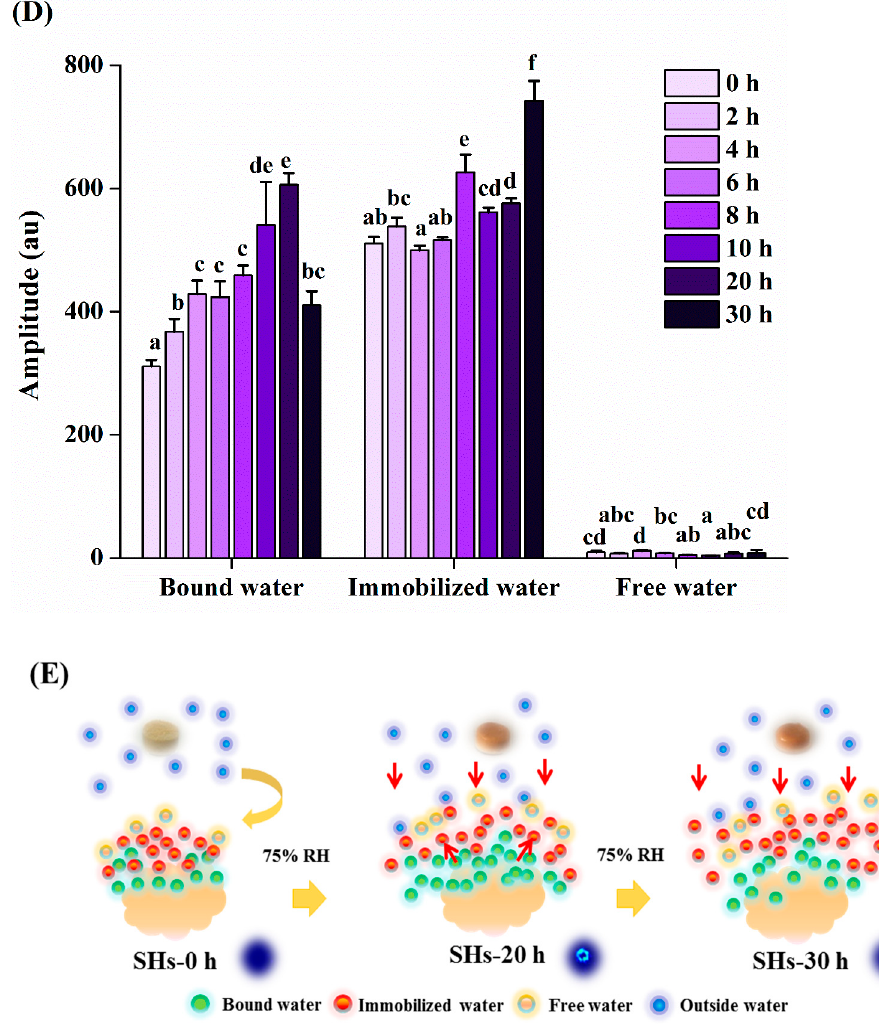
Figure 2. ( A ) The changes of appearance shape and weight of SHs flour absorbing the moisture at 25 ◦ C and RH 75% at different storage times. ( B ) MRI pseudo-color images of SHs flour absorbing the moisture at 25 ◦ C and RH 75% at different storage times. ( C ) LF-NMR T 2 relaxation time distribution curves of SHs flour under the condition of 25 ◦ C and RH 75% at different storage times. ( D ) Changes of water distribution in SHs flour during the process of storage. ( E ) Simplified models to illustrate the three types of water distribution in the SHs flour in the system of moisture absorption. The SHs-0 h, SHs-2 h, SHs-4 h, SHs-6 h, SHs-8 h, SHs-10 h, SHs-20 h, and SHs-30 h respectively represent the SHs flour stored for 0, 2, 4, 6, 8, 10, 20, and 30 h.